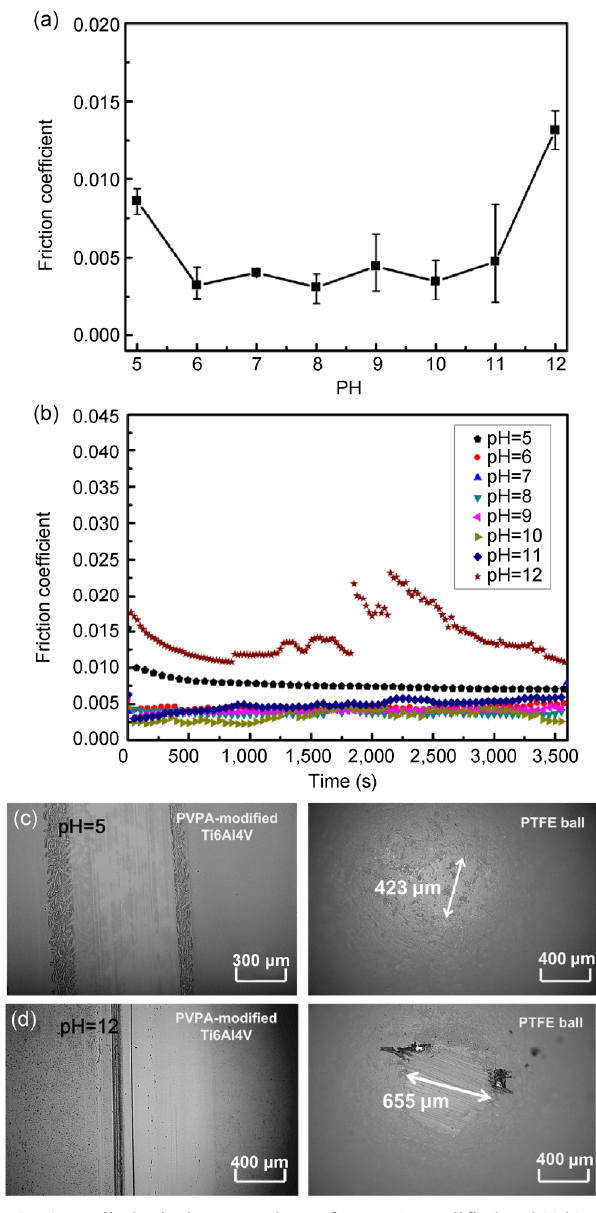
Fig. 3 Tribological properties of PVPA-modified Ti6Al4V lubricated by PBS with different pH values: (a) average friction coefficients versus pH, (b) curves of friction coefficients versus time for pH values in the range of 5 to 12, (c) wear patterns at a pH of 5, and (d) wear patterns at a pH of